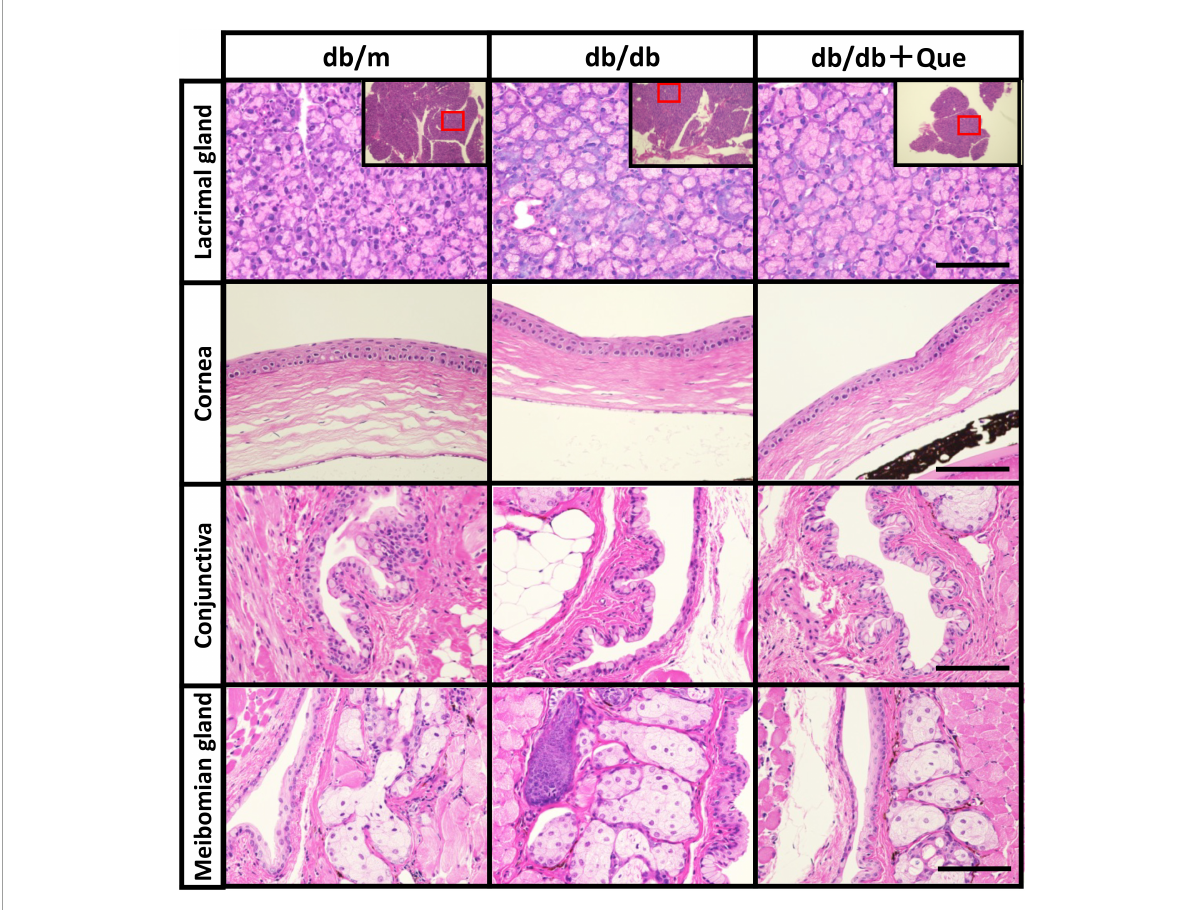
FIGURE2 Histological examination of eye tissues. Light microscope images of hematoxylin/eosin-stained sections of the lacrimal glands, cornea, conjunctiva and meibomian glands from each experimental group were recorded. Scale bar: 50 µ